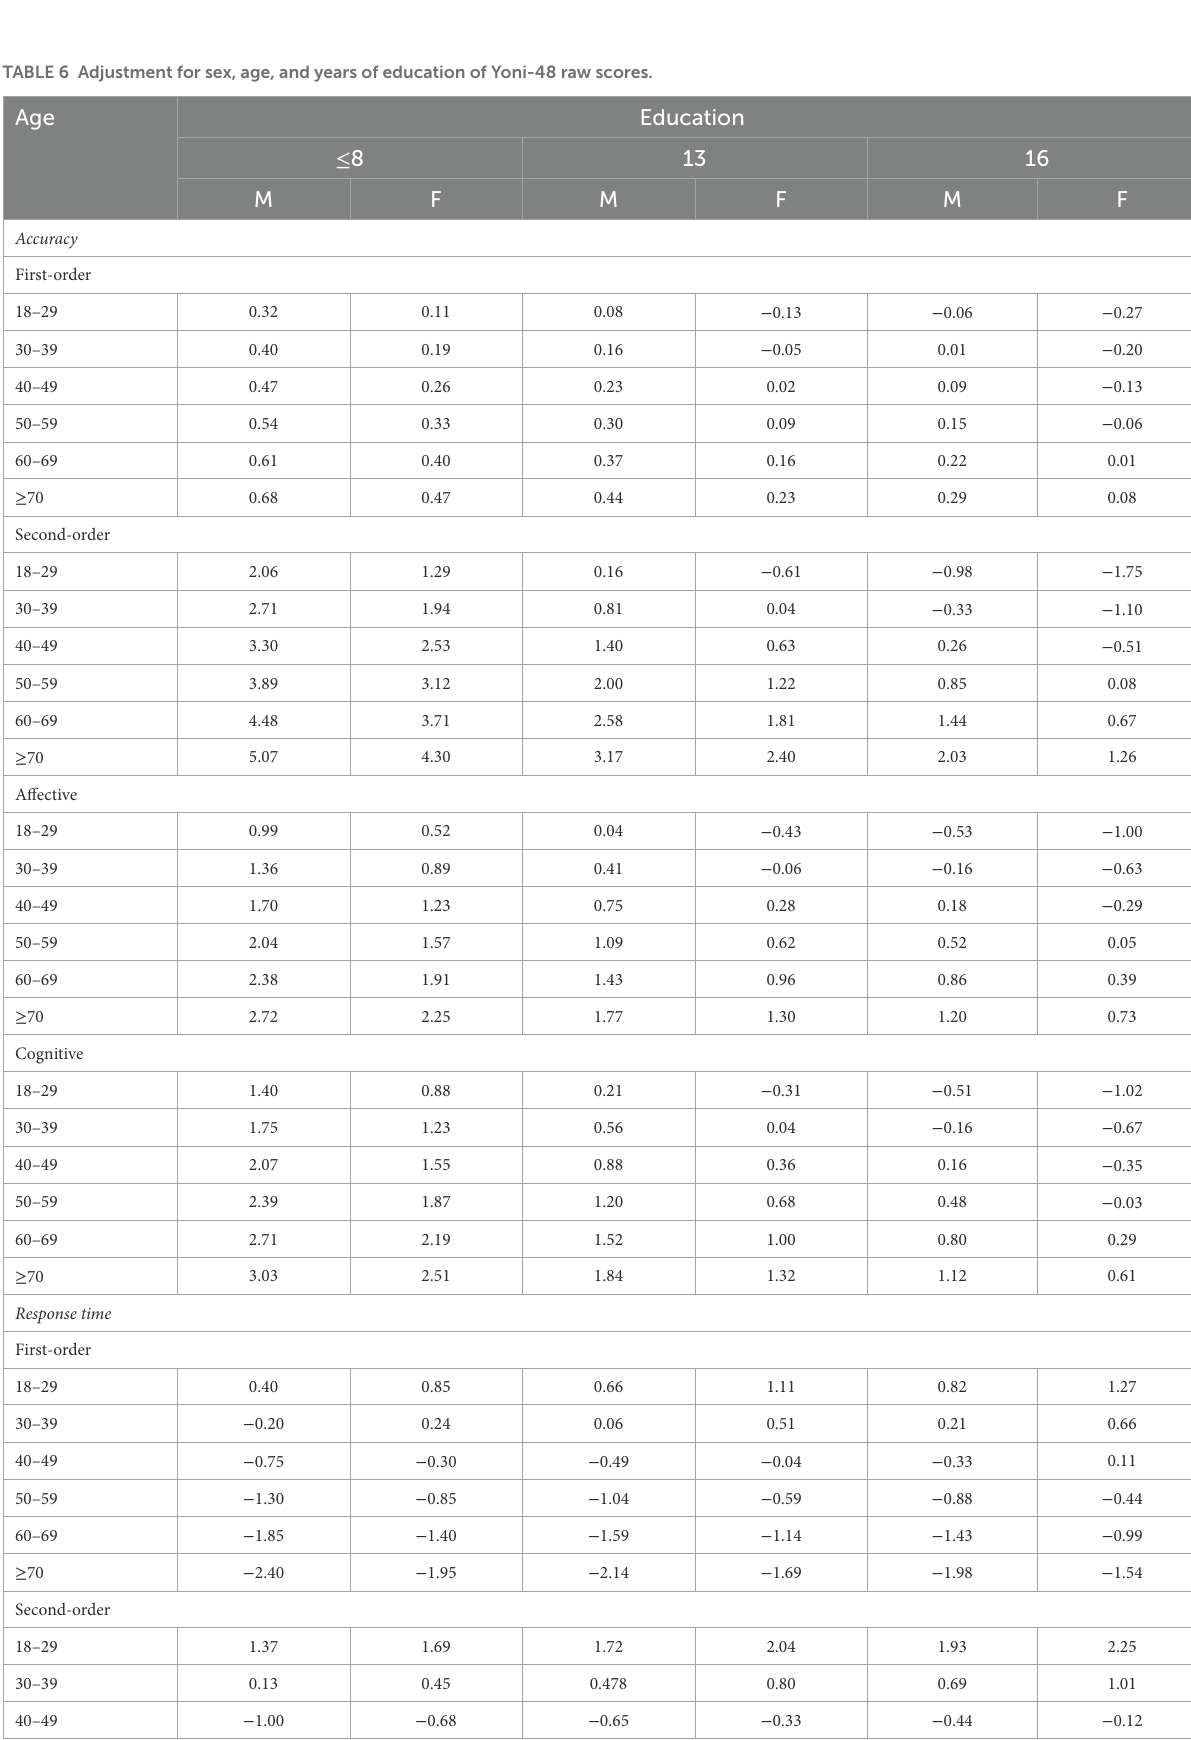
TABLE 6 Adjustment for sex, age, and years of education of Yoni-48 raw